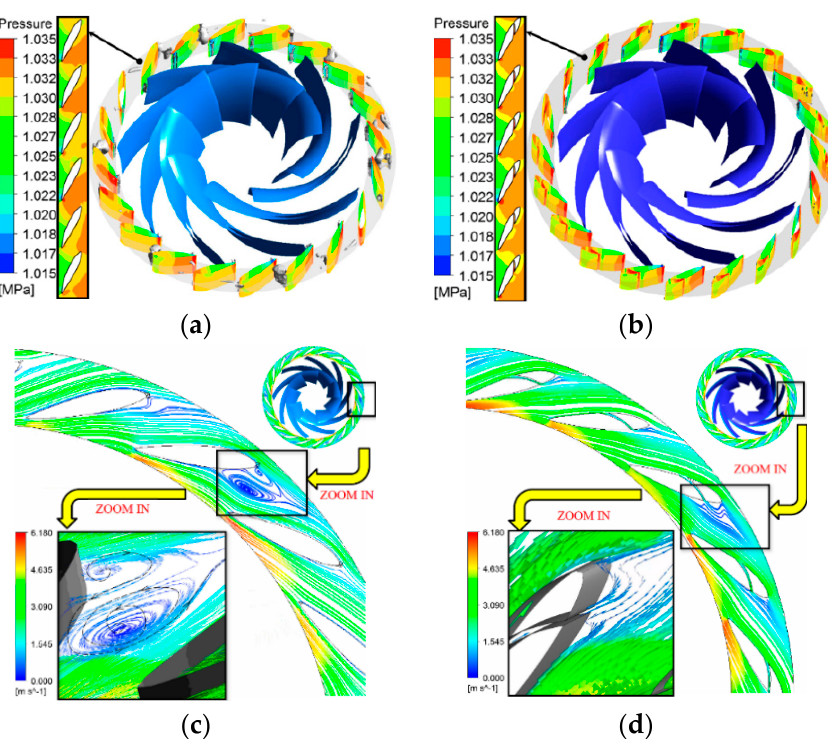
Figure 14. Influence of “Groove Method” on pressure field and flow field under stall point. ( a ) Pressure field in the original guide vane; ( b ) Pressure field in the modified guide vane; ( c ) Pressure field in the modified guide vane; ( d ) Flow field in the modified guide vane.